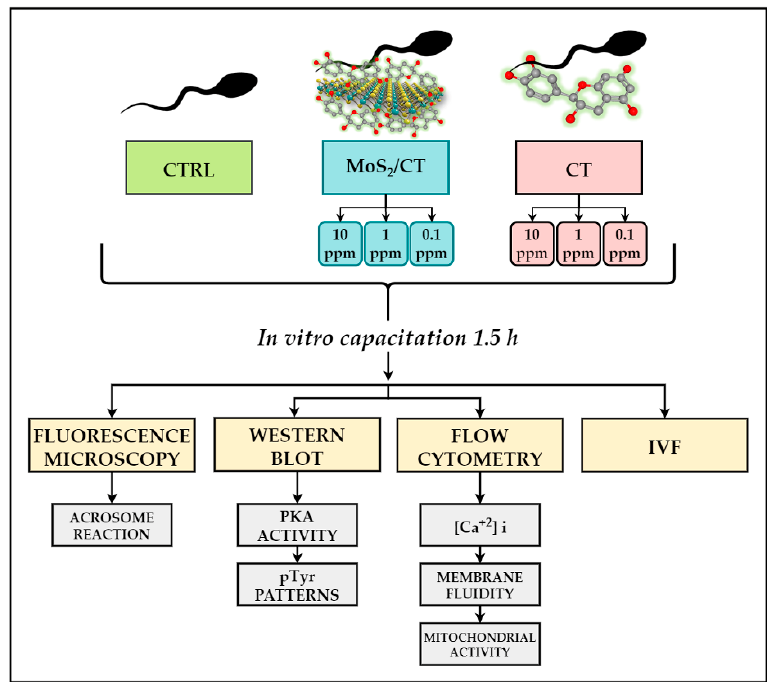
Figure 8. Experimental design. Spermatozoa were exposed to MoS 2 functionalized with catechin at different concentrations (10, 1, 0.1 ppm), catechin alone at the same concentrations (10, 1, 0.1 ppm) for 1.5 h in capacitation medium, a control group (CTRL) was maintained. Different sperm capacitation events were analyzed: acrosome damage, membrane fluidity, mitochondrial activity, intracellular calcium concentration, biochemical phosphorylation patterns and IVF assays.